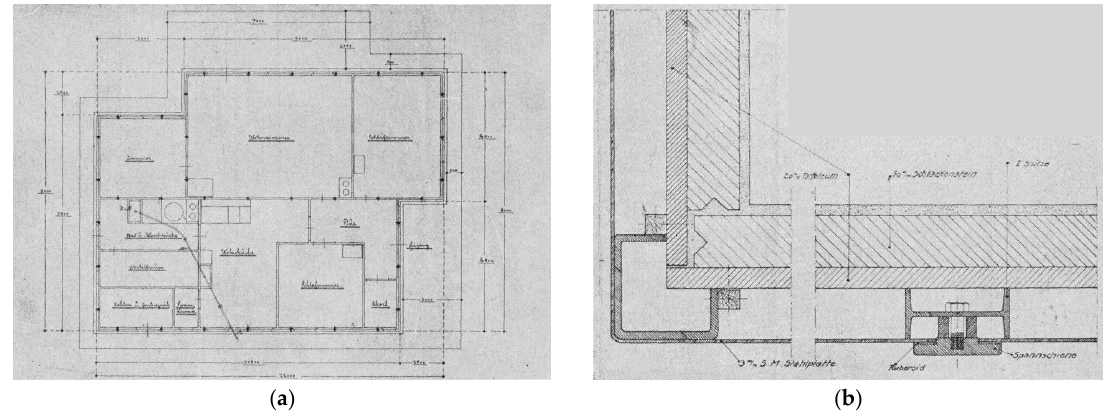
Figure 10. Georg Muche and Richard Paulick: Steel House in Dessau-Törten, 1926—Floor plan and façade construction detail. Drawings taken from (Muche 1927b, p. 4).